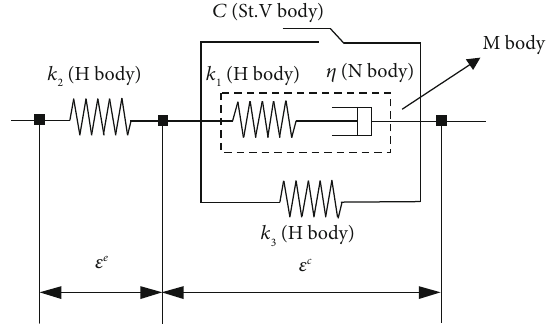
Figure 11: Basic memory